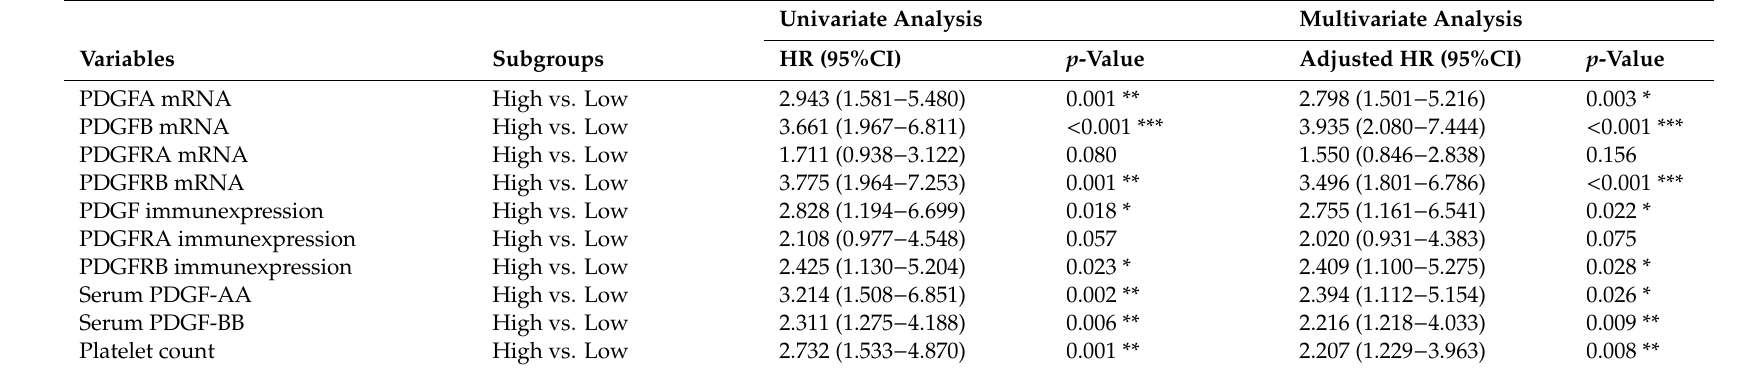
Table 4. Univariate and multivariate analysis of risk factors for overall